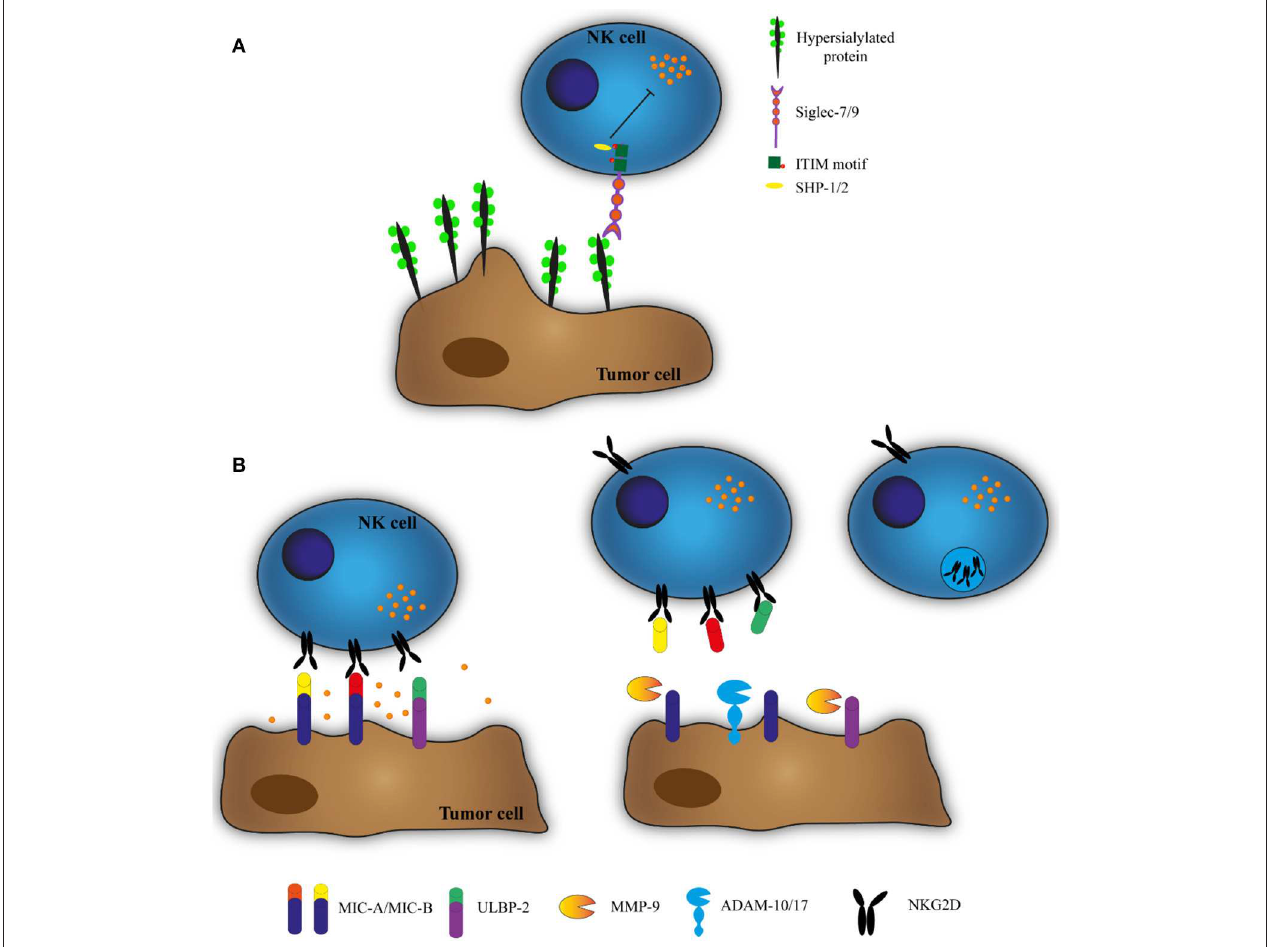
FIGURE 1 | (A) Hypersialysation of tumor cells inhibits NK cell cytotoxicity. To impair recognition by NK cells, tumor cells change their glycosylation pattern, expressing more sialic acid on the cell membrane. NK cells express membrane receptors that recognize this sialic acid (Siglecs). Siglecs have an intracellular immune receptor tyrosine-based inhibition motif (ITIM) that recruits tyrosine phosphatases SHP-1 and SHP-2 and inhibits NK cell cytotoxicity. (B) ADAMs and MMPs cleave MIC-A, MIC-B, and ULBP-2 and downregulate NKG2D expression. NK cells can recognize and kill target cells by the interaction between the stimulatory receptor NKG2D and the ligands MIC-A, MIC-B, and ULBP-2. However, the TME contains ADAMs and MMPs that cleave these ligands, allowing the soluble proteins to bind to NKG2D and stimulate its degradation.